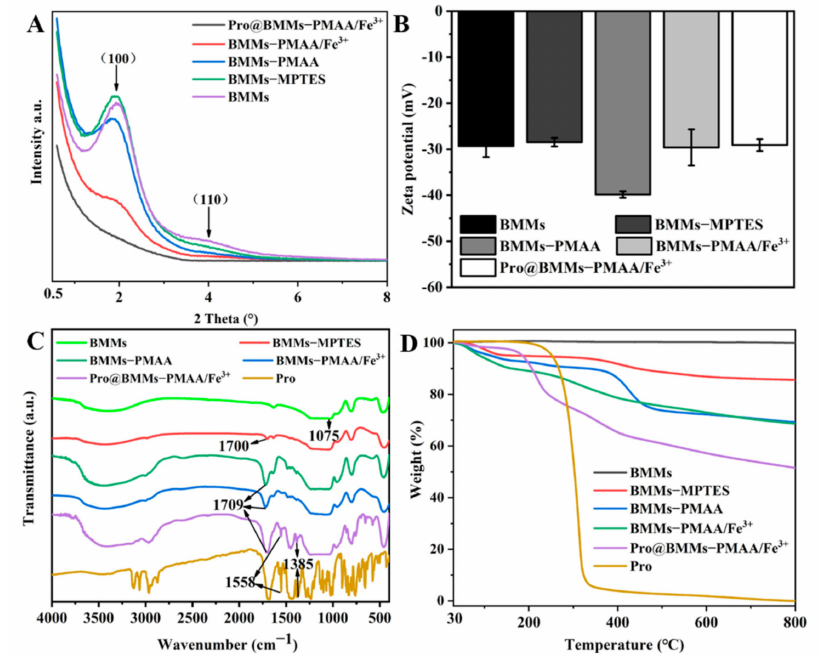
Figure 4. XRPD diffractograms ( A ), zeta potentials ( B ), FTIR spectra ( C ), and TGA curves ( D ) of BMMs, BMMs − MPTES, BMMs − PMAA, BMMs − PMAA/Fe 3+ , and Pro@BMMs − PMAA/Fe 3+